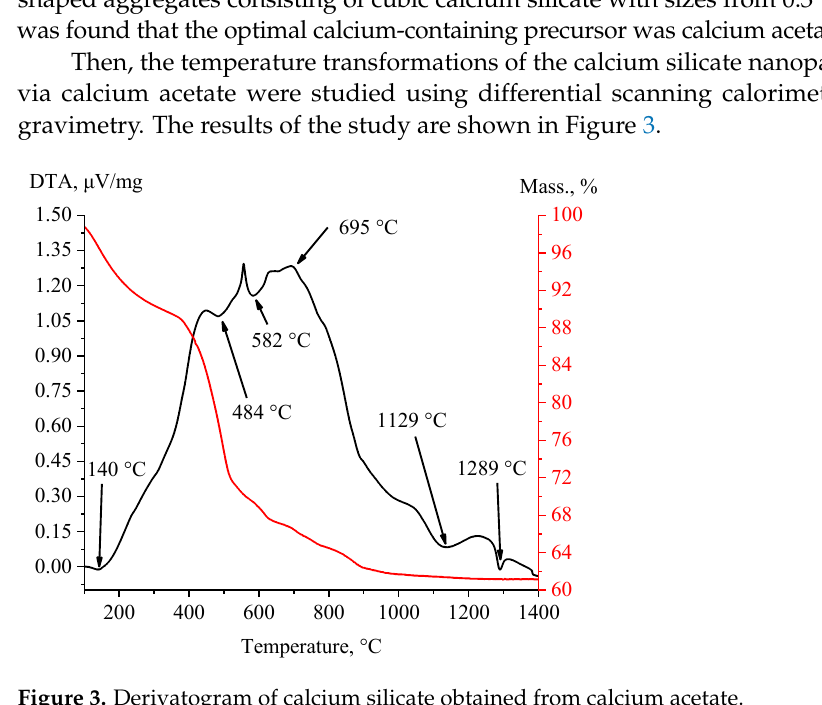
Figure 2. SEM micrographs of calcium silicate nanoparticles obtained from: ( a ) calcium acetate, ( b ) calcium chloride, ( c ) calcium chloride (other section), ( d ) calcium nitrate.